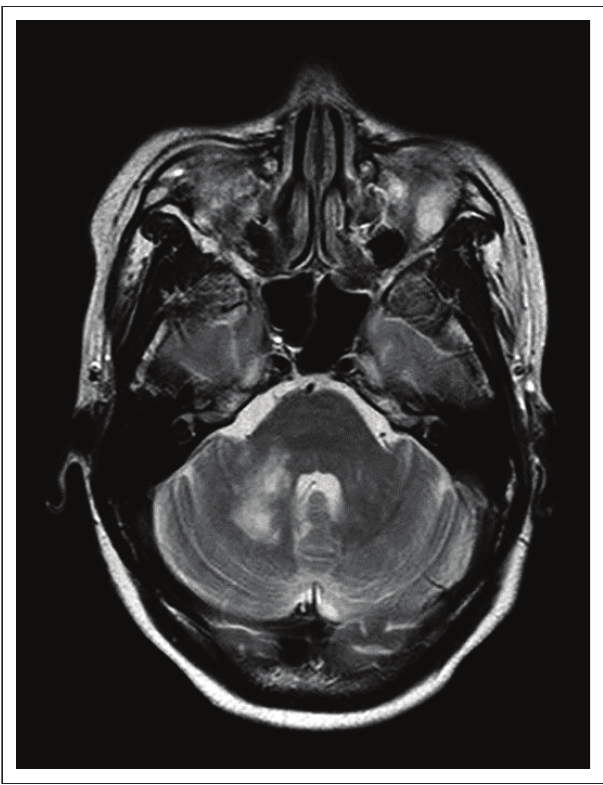
FIGURE 6: Axial T2 weighted image of the patient in Case 6, showing high-signal changes in the right cerebellum and cerebellar peduncle.